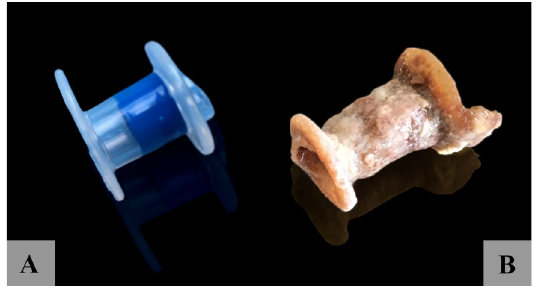
Figure 8. Figure presents Provox voice prostheses. Panel ( A ) shows a completely new prosthesis. Panel ( B ) shows the voice prosthesis after 26 months of use. Its surface is covered with